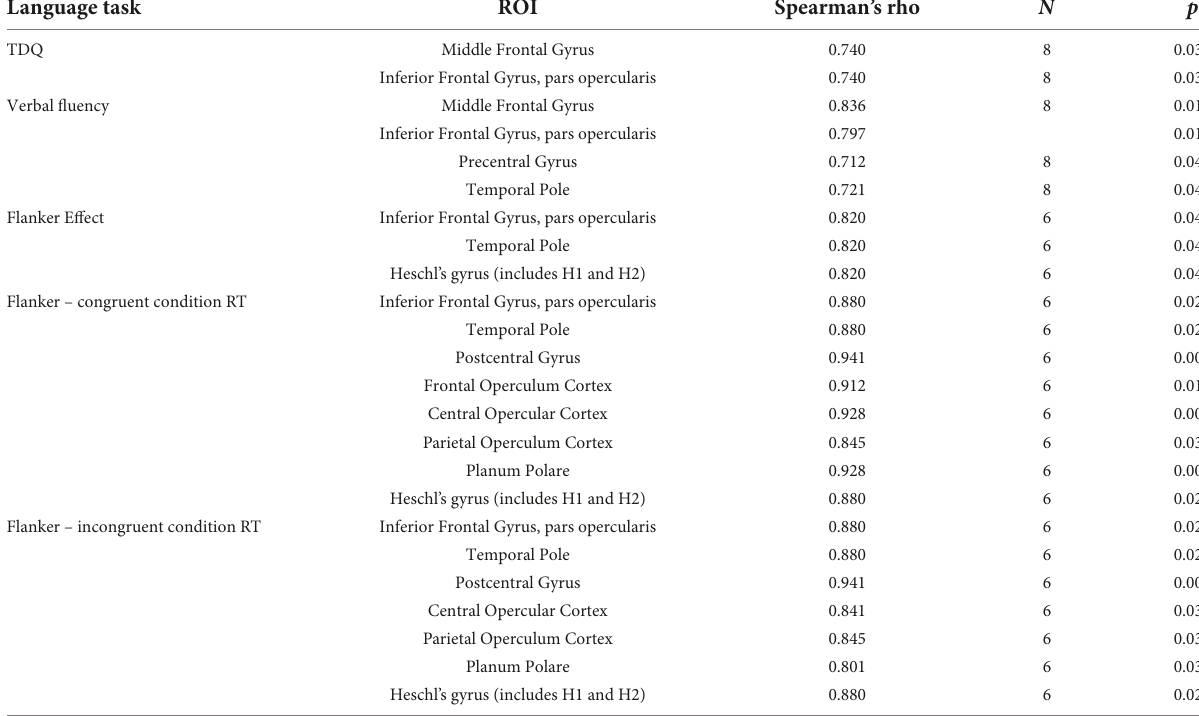
TABLE 6 Significant correlations between damaged voxels within ROI and pre-therapy standardized language scores and cognitive control performance outcomes. Language